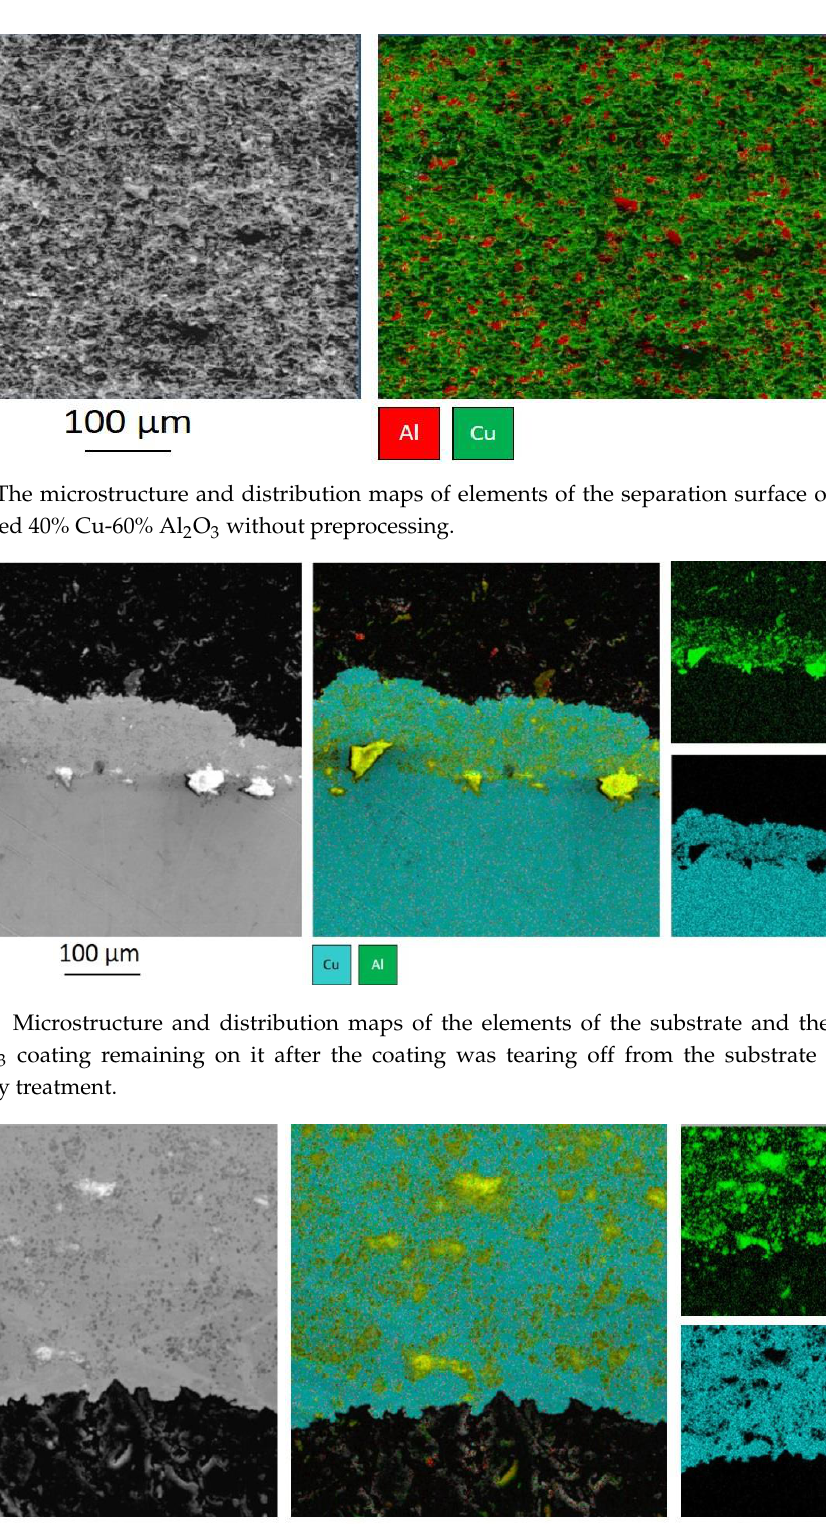
60% Al 2 O 3 coating after tearing off the coating from the substrate without preprocessing.